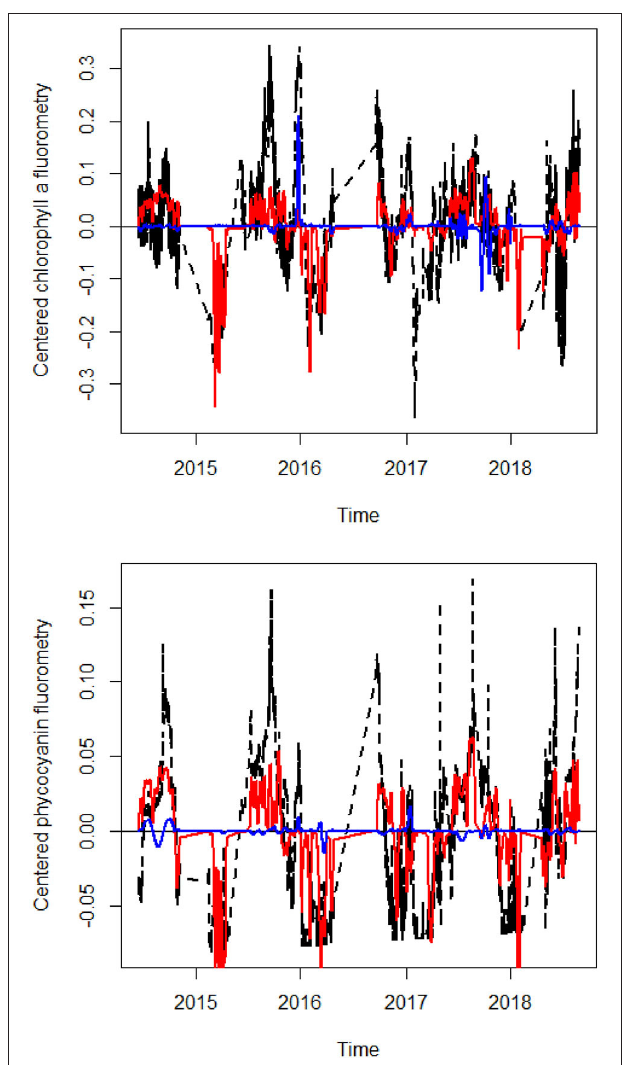
FIGURE 3 | Line plots of daily chlorophyll a and phycocyanin flurorometry, along with their fitted values according to the sets of dbMEM variables related to water temperature. Observed values are in black, fitted values relating to dbMEM variables related to water temperature are in